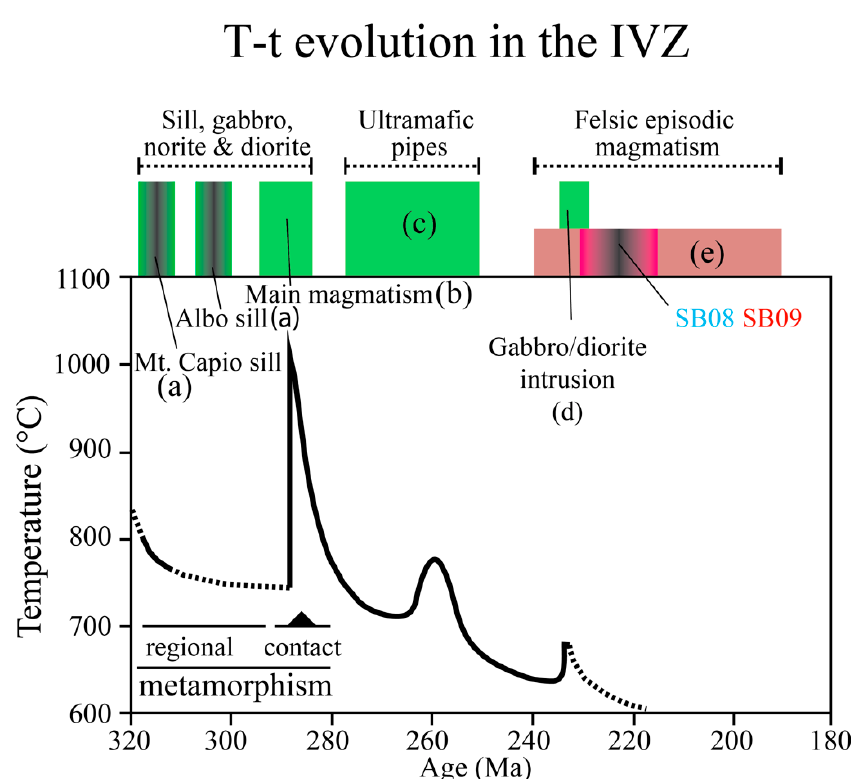
Figure 13. Temperature and time (T-t) plot for the central and southern part of IVZ, modified after Ewing et al. [51,115] and Klötzi et al. [53]. The black line indicates T-t evolution of high-grade metamorphic rocks. Magmatic events occurred in the IVZ from Permian to Jurassic are also shown at the top of the T-t plot. Green and pink boxes refer to zircon 206 Pb / 238 U age data from mafic / ultramafic and felsic compositions, respectively. References: ( a ) [53]; ( b ) [49]; ( c ) [51,56,58] ( d ) [60]; ( e ) [14,20,22,62]. The intrusion age for the studied felsic dykes are also shown.